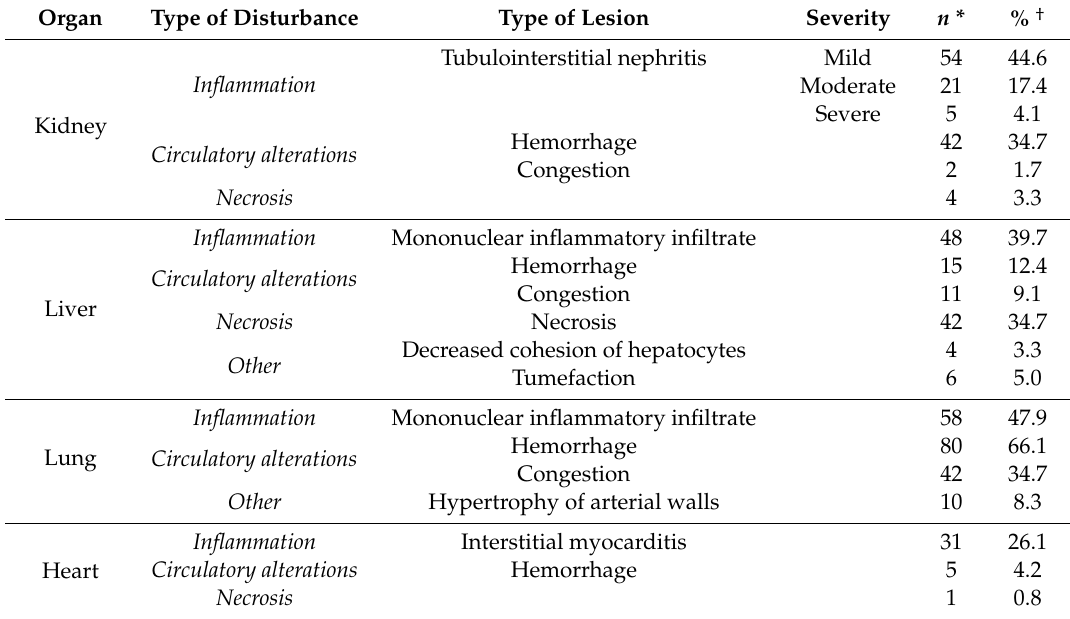
Table 2. Main histopathological findings from 119 rodents trapped in the Los R í os Region, Chile, whose histology was consistent with infection in any sample. Note that an animal could have more than one lesion in each